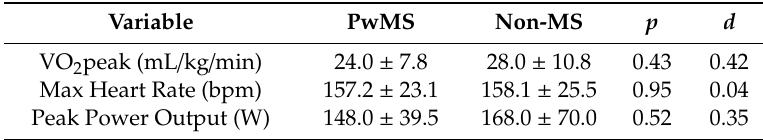
Table 3. Physiological variables during the initial incremental cycling